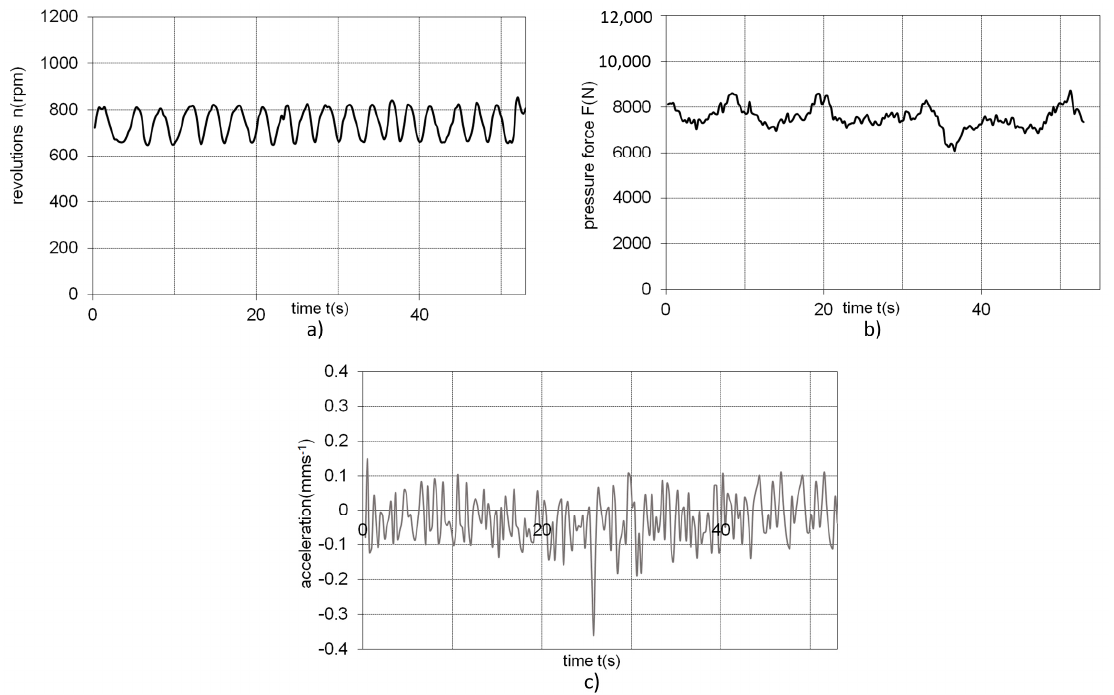
Figure 7. Time courses of measured parameters, ( a ) revolutions, ( b ) pressure force, ( c ) vibration signal of acceleration.